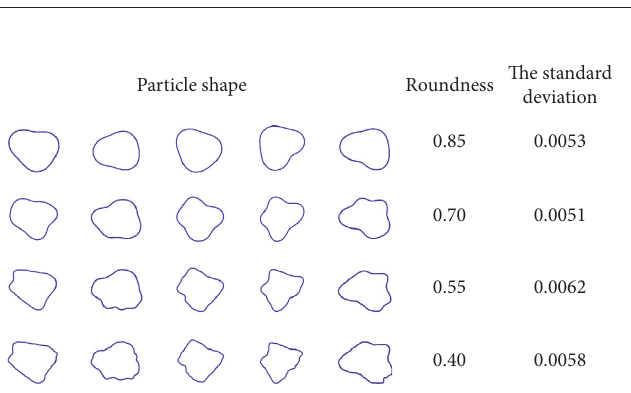
Figure 13: Two-dimensional particle models with different roundnesses.